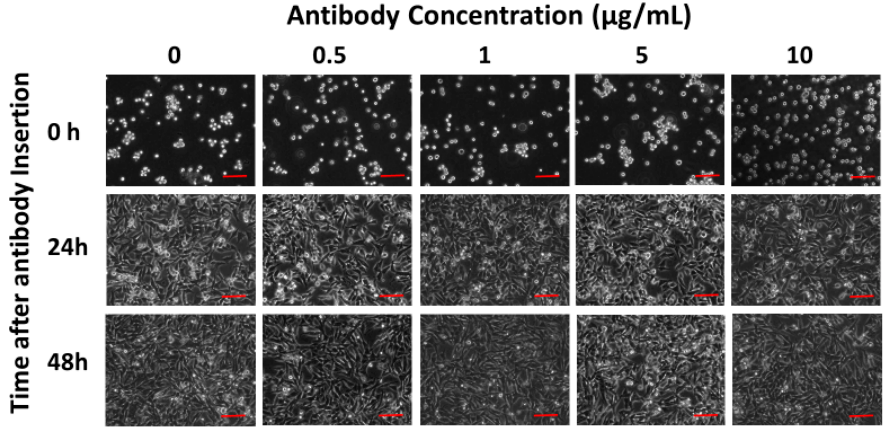
Figure 2. Morphological changes in the Vero cells 0, 24 and 48 h after electroinsertion of 0, 0.5, 1, 5 and 10 μ g/mL of SARS-CoV-2 Spike S1 antibody. Scale bars = 50 μ m.